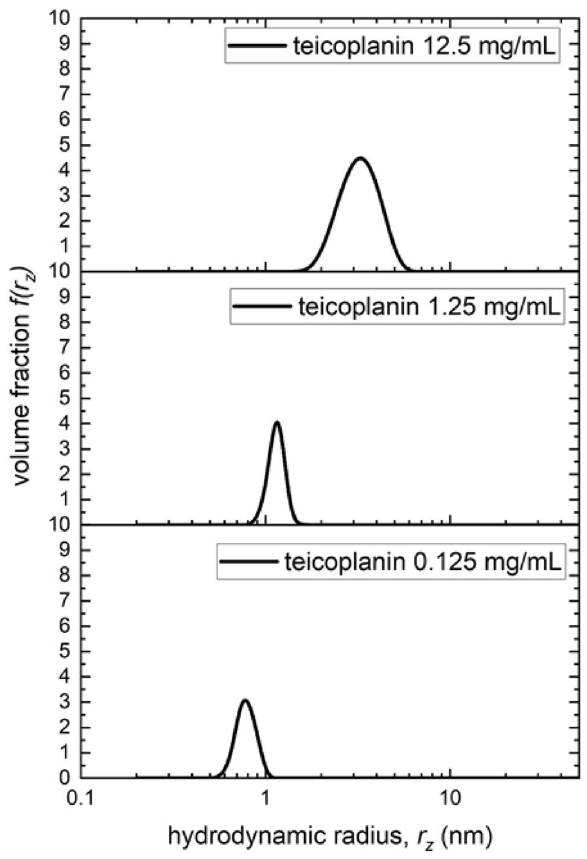
Figure 5. Distribution of z-average hydrodynamic radii obtained from dynamic light scattering measurements at 20.0 °C for teicoplanin in solution at concentrations 12.5, 1.25 and 0.125 mg/mL.